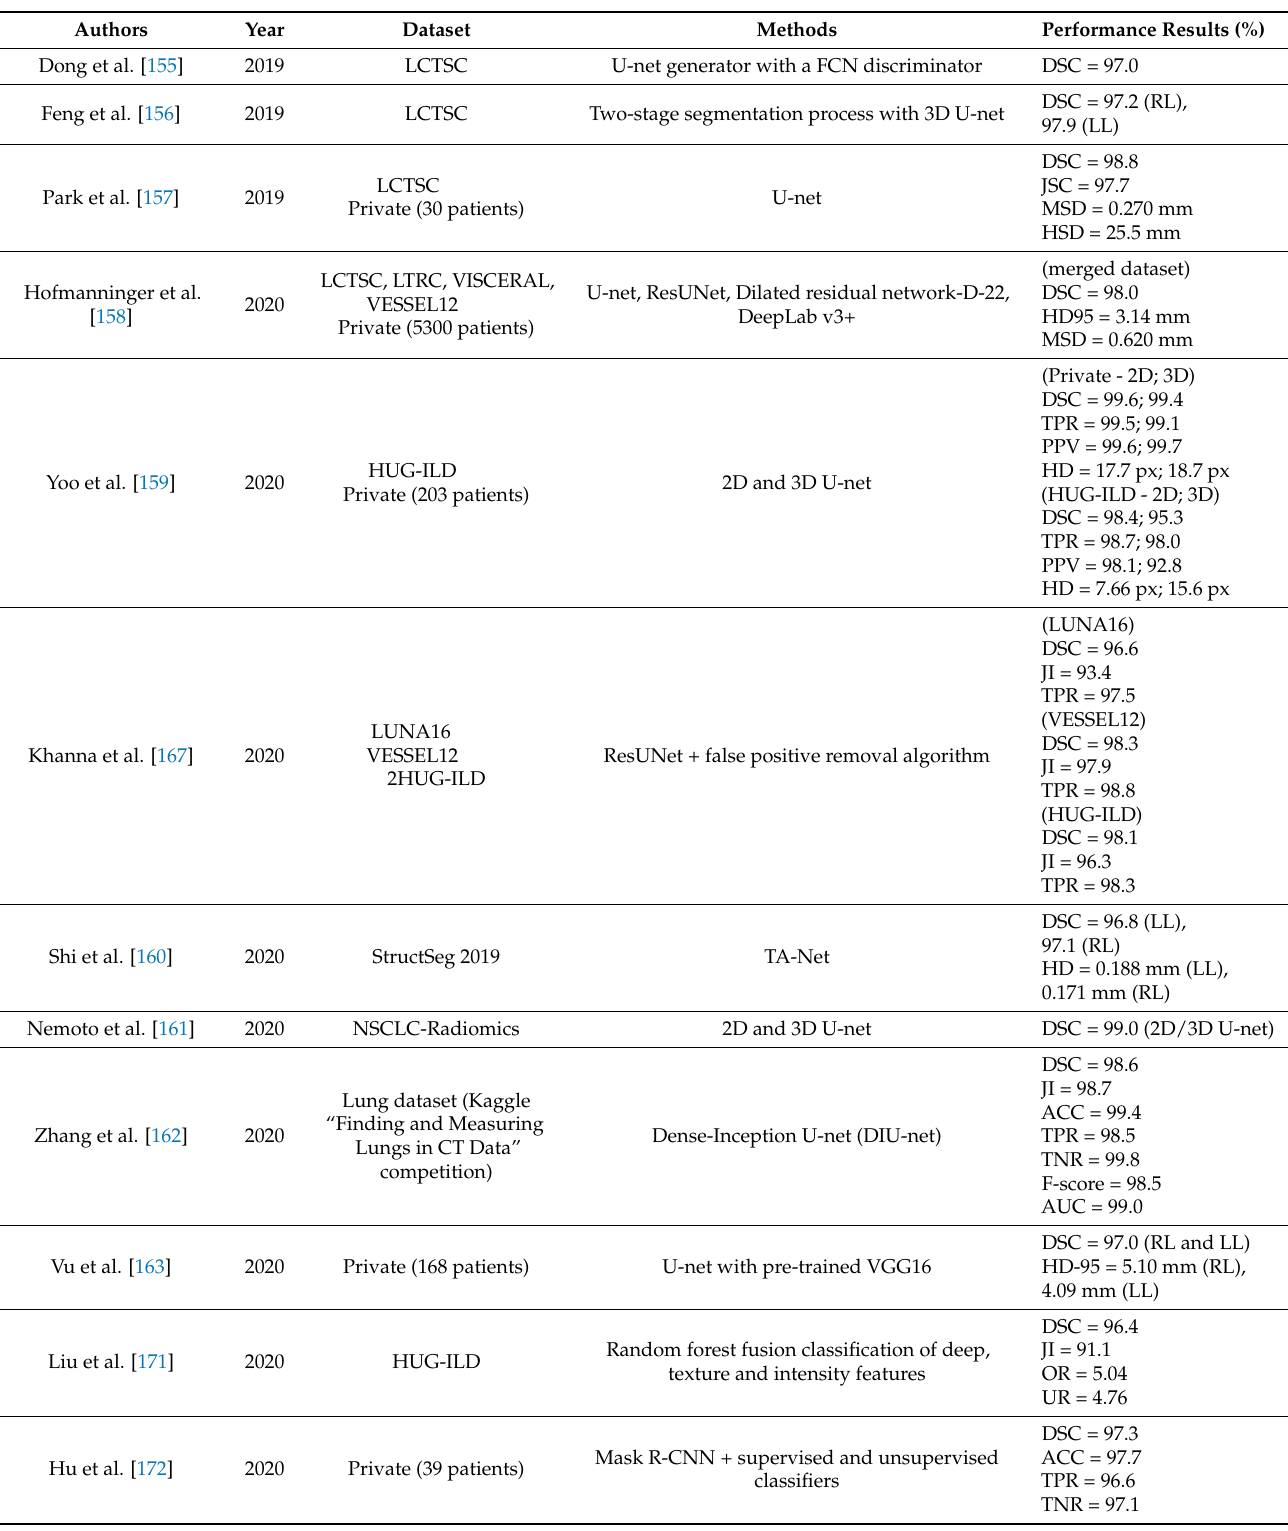
Table 5 summarizes the reviewed machine/deep learning methodologies for lung segmentation in chronological order. Table 5. Overview of published works regarding learning-based methodologies for the segmentation of lung CT images